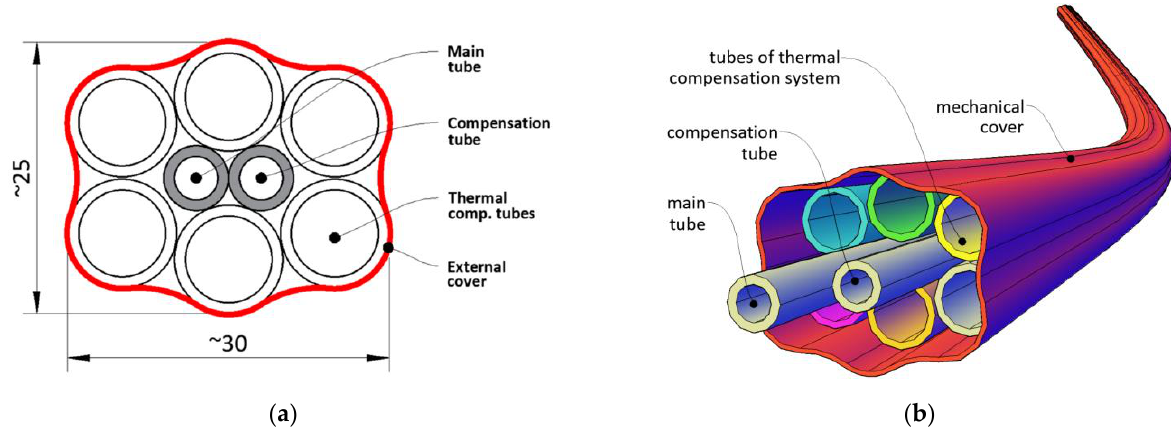
Figure 5. Design of new hydraulic sensor SHM Profiler: ( a ) cross section; ( b ) spatial visualization.